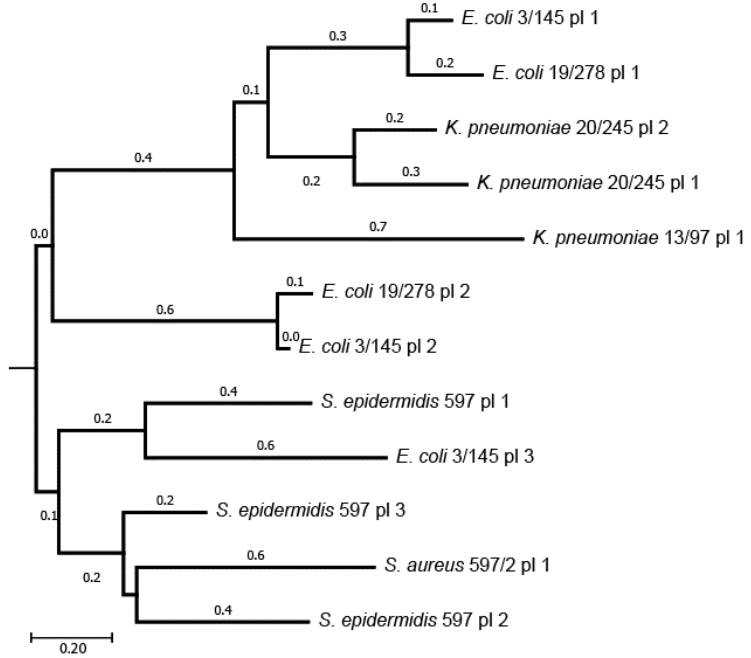
Figure 1. Genealogical tree of plasmids of the selected isolates.